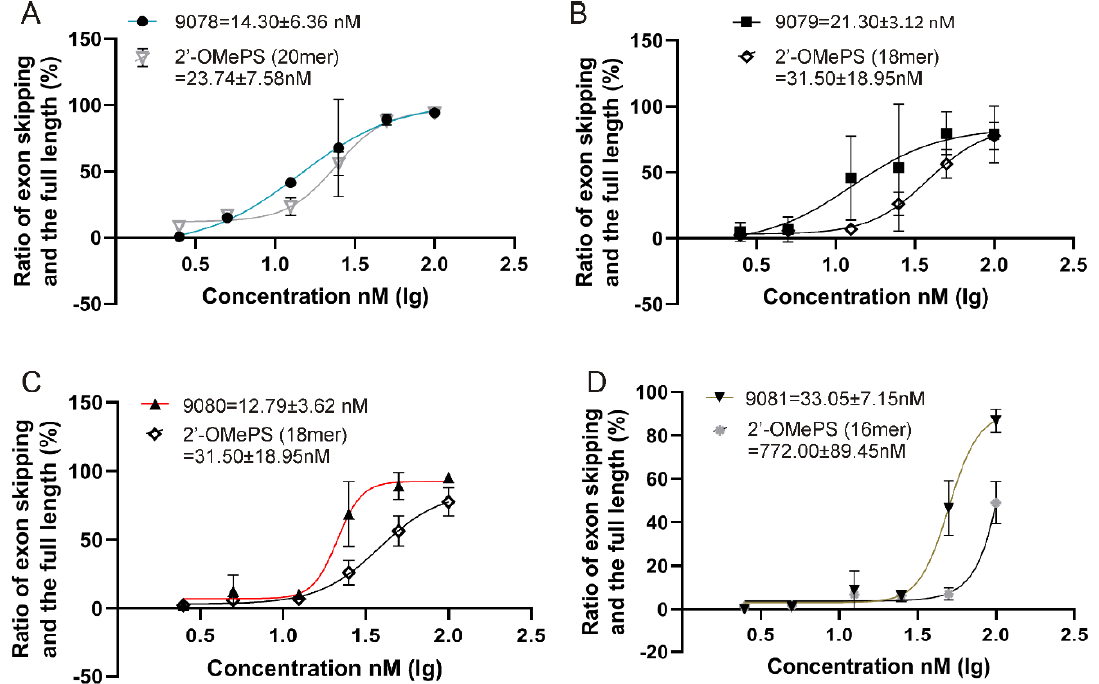
Figure 7. Evaluation of half maximal effective concentration (EC 50 ) of the AOs vs. their corresponding 2′ -O-methyl phosphorothioate ( 2′ -OMePS) control AO (Error bars represent the standard deviation of mean). ( A ) NAC 9078 vs 2′ -OMePS control AO (20mer); ( B ) NAC 9079 vs 2′ -OMePS control AO (18mer); ( C ) NAC 9080 vs 2′ -OMePS control AO (18mer); ( D ) NAC 9081 vs 2′ -OMePS control AO (16mer).